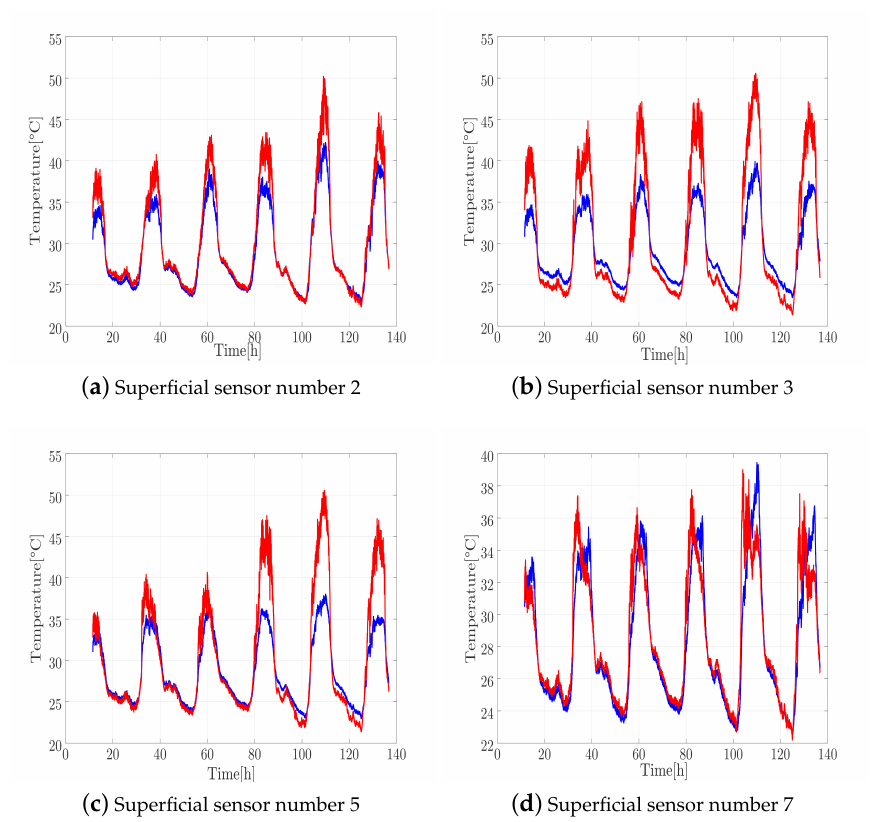
Figure 4. Surface temperatures registered at different points of the geodesic dome.